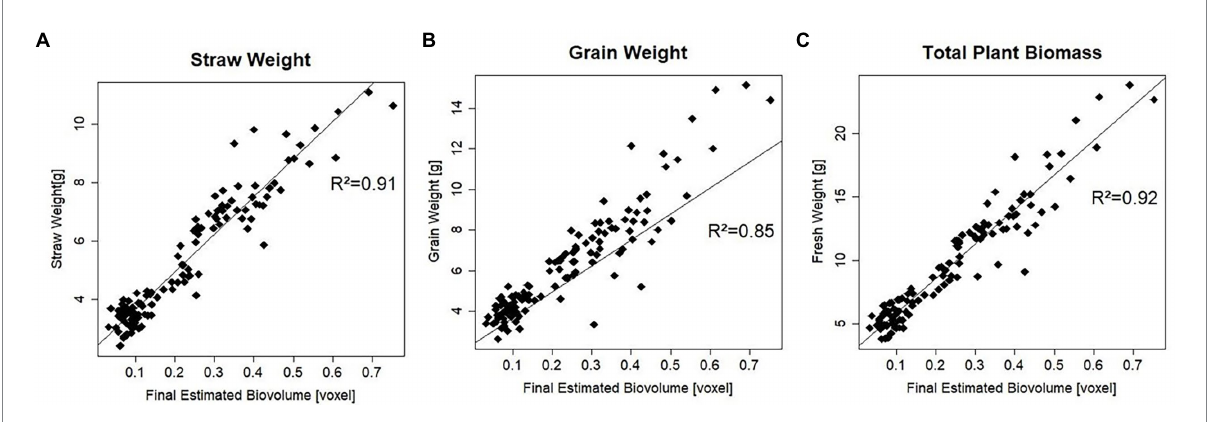
FIGURE 2 Coefficient of determination ( R 2 ) of manually measured traits at maturity with final estimated biovolume for all 120 plants. (A) Coefficient of determination with plant straw weight. (B) Coefficient of determination with plant grain weight. (C) Coefficient of determination with plant